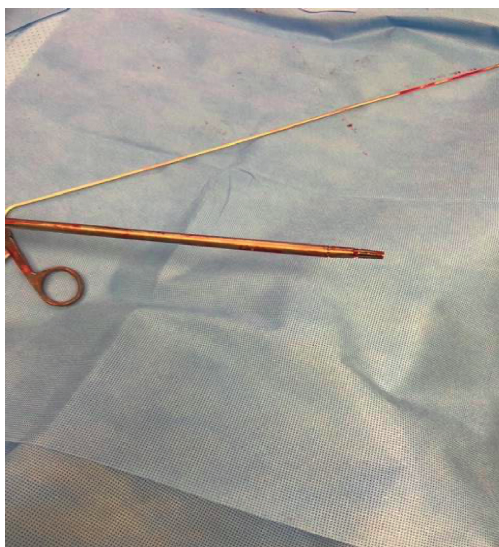
Figure 3: Gross picture of the 6.4mm male rod retriever cannulated over the fractured 3.2mm male rod retriever locking mechanism with a small portion protruding.